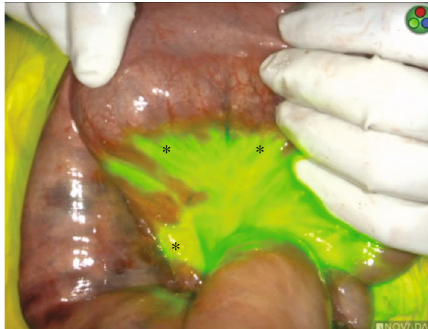
Figure 6: Perfusion to edge of mesentery but not beyond ( ∗ ) indicating nonperfusion to serosa and mucosa of the small intestines (a) and large intestines